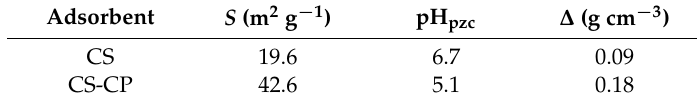
Table 2. Characteristics of corn stalks (CS) before and after modification by cationic